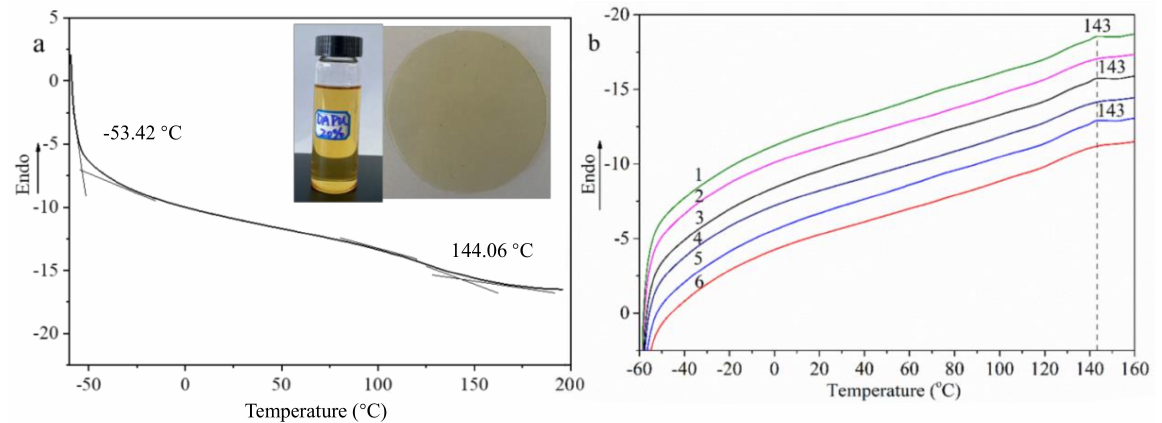
Figure 4. DSC curve of DA-PU ( a ) and DSC curves of the reversibility test of the sample ( b ); 1–6 in Figure 3b are (1) DA0, (2) rDA1, (3) DA1, (4) rDA2, (5) DA2, and (6) rDA3. The insets in Figure 3a are prepolymer DA-PU of 20 wt% and cured DA-PU film.